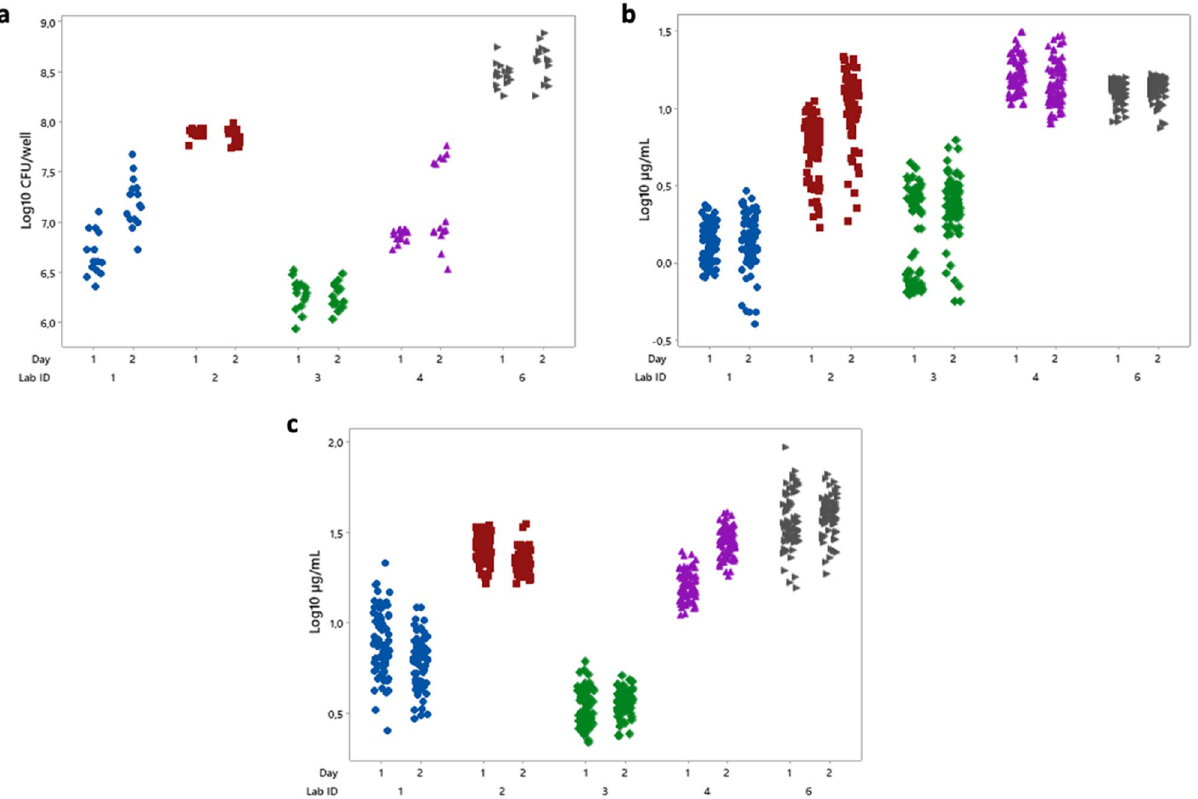
Figure 1. Control experiment data for the ILP protocol. Along the horizontal axis are listed the lab IDs and the two experimental days within each lab. Horizontal jitter has been applied to better visualize data points. ( A ) Plate count—Each point in the graph is the log density (LD = log10(CFU/well)) of biofilm bacteria grown on a single well. ( B ) Resazurin—Each point in the graph is the log 10 resorufin concentration (µg/mL) of biofilm bacteria grown on a single well. ( C ) Crystal violet—Each point in the graph is the log 10 crystal violet concentration (µg/mL) of biofilm bacteria grown on a single well.